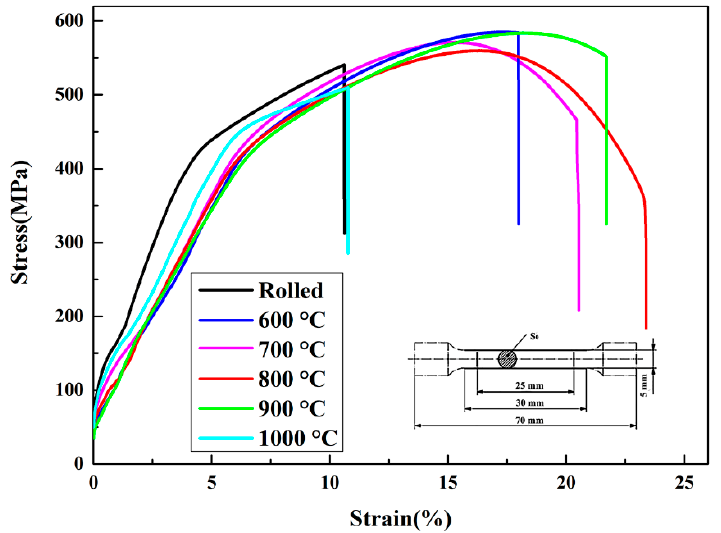
Figure 9. Engineering stress-strain curves for rolled and heat treated at 600~1000 °C of Fe-25Cr-5Al- RE wire rods.